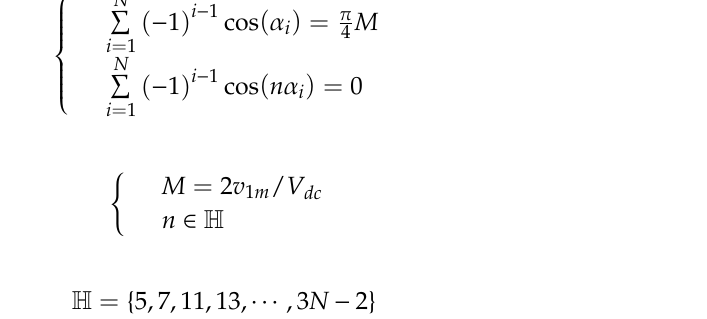
Figure 4. Dead time generation circuit. A bridge arm of the three-level NPC converter outputs three voltage levels, i.e., 𝑉 (cid:3031)(cid:3030) /2 , 0, −𝑉 (cid:3031)(cid:3030) /2 , denoted as 1, 0, − 1. Under an ideal SHE modulation, the bridge arm outputs exactly the same PWM waveform as in Figure 2 by comparing the real-time phase angle of the modulation voltage with the switching angles, and achieves the desired output harmonic performance. However, performance is degraded due to the addition of the dead time and the non-ideal characteristics of the semiconductor devices. The detailed current path and output voltage during the dead time is shown in Figures 5 and 6. Compared with the ideal SHE-PWM waveform, the output voltage square wave is widened or narrowed according to the current polarity, and the phase angle of the modulation voltage. Specifically, in the positive half cycle of the modulation voltage, as shown in Figure 5a, only switch 𝑆 (cid:2870) is turned on during the dead time and the current is forced through the clamped diode or the freewheeling diode. The red dashed-line and green half-dashed-line correspond to the positive current path and negative current path, respectively. As a consequence, during the dead time the bridge arm outputs level 0 at positive current polarity as in Figure 5b, and level 1 at negative current polarity as in Figure 5c. The shadowed parts denote the output voltage error compared with the ideal SHE-PWM waveform. Noted that 𝛿 (cid:3031) (in radians) is the equivalent dead time considering the